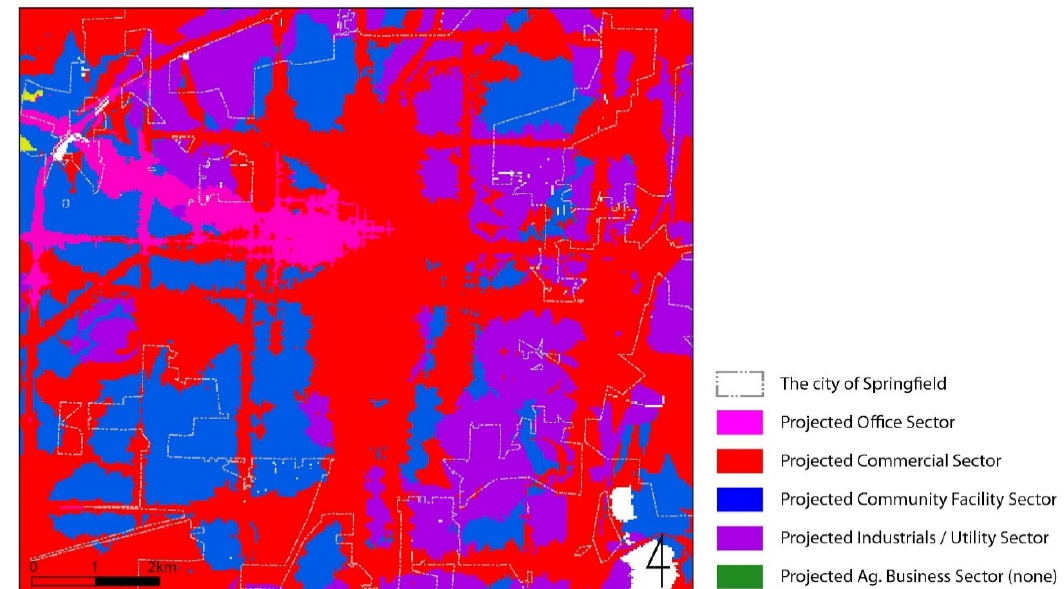
Figure 2. Sectoral classifications of economic growth